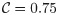
Settling of a triaxial ellipsoid on a flat surface.a) and b) Projections of the particle on Cartesian coordinate planes with correlated scales are shown for the initial orientation. c) and d) Angular velocity and time series of the particle with damping coefficient C=0.75 are shown. e) and f) Angular velocity and time series of the particle with damping coefficient C=1.5 are shown.